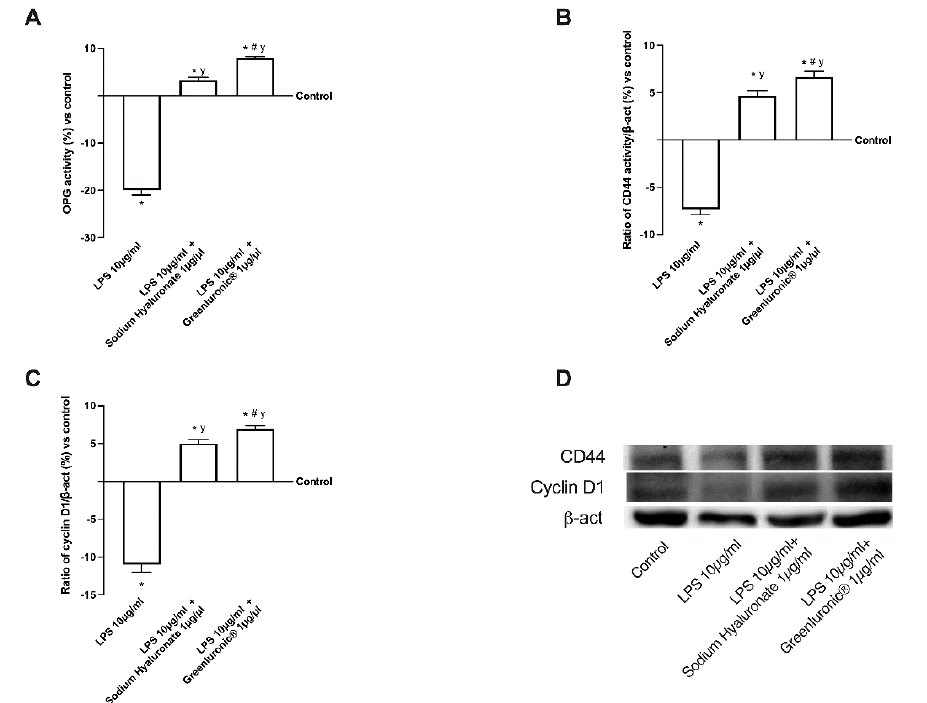
Figure 8. Western-blot and densitometric analysis of the main intracellular pathways activated in T/C-28a2 cells during AO conditions. In ( A ) OPG activity measured by ELISA test, in ( B ) the CD44, and in ( C ) cyclin D1 densitometric analysis of the specific Western blot, which is reported as an example in ( D ). Data are mean ± SD of five independent experiments performed in triplicates compared to control value (0% line). * p < 0.05 vs. control; y p < 0.05 vs. 10 µg/mL of LPS; # p < 0.05 vs. Sodium Hyaluronate 1 µg/µL .